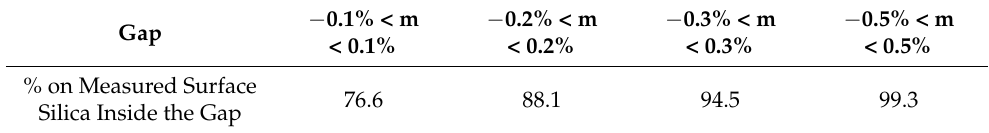
Figure 14. Map of m, the relative homogeneity from the reflection of silica sample at 50° (R p = 0.231%). Table 2. Relative variation in reflection of the silica sample measurement in p-polarization.